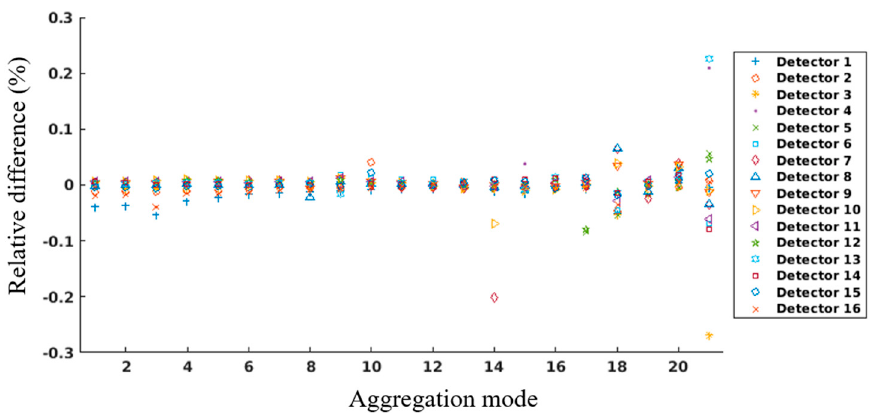
Figure 4. Relative difference between the prelaunch LGS EV gains calculated with a linear fit allowing nonzero constant term and with a linear fit forced through the origin. Data for HAM side A are shown. The relative difference is calculated by 100% × (G 1 − G 2 )/G 2 , where G 1 and G 2 are the prelaunch LGS EV gains calculated with a linear fit allowing nonzero constant term and with a linear fit forced through the origin respectively.